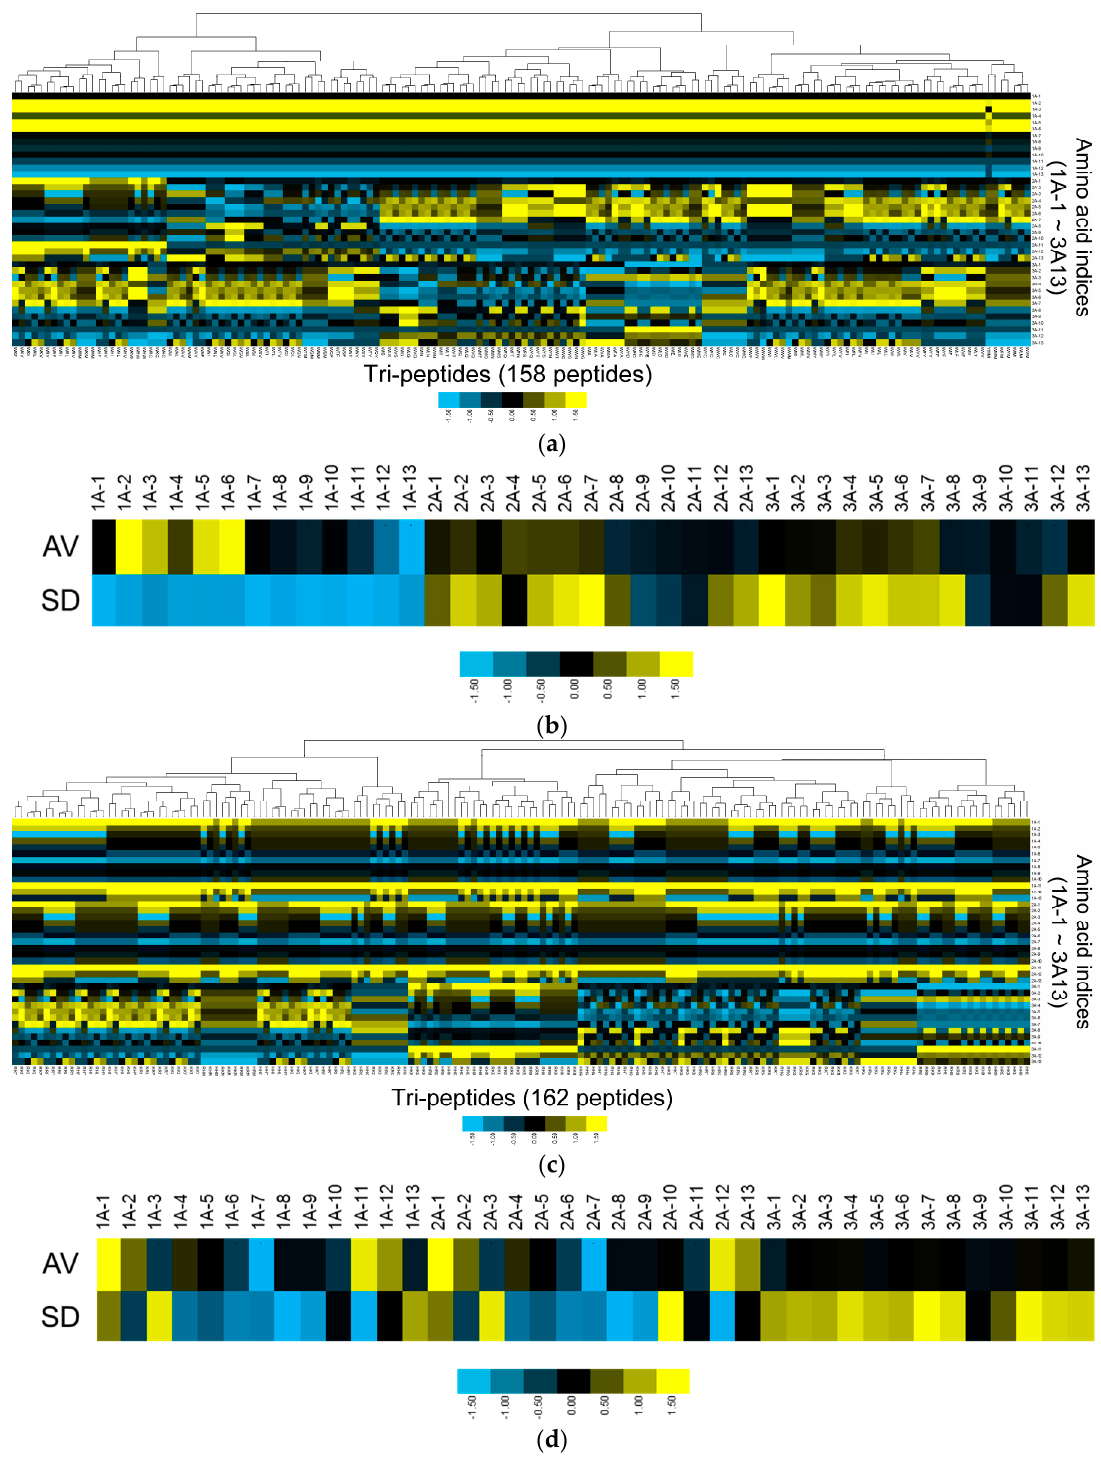
Figure 4. Physicochemical property analysis for cluster 21 (Col IV-selective adhesion peptides) and cluster 12 (Col I-selective adhesion peptides). ( a ) Heat map showing patterns of amino acid indices at each residue in cluster 21; ( b ) Averages and standard deviations of amino acid indices at each residue within cluster 21; ( c ) Heat map showing patterns of amino acid indices at each residue in cluster 12; ( d ) Averages and standard deviations of amino acid indices at each residue within cluster 12. Amino acid indices are designated as “position-index number”. For example, 1A-1 represents index 1 at the first amino acid (1A) in the tripeptide.